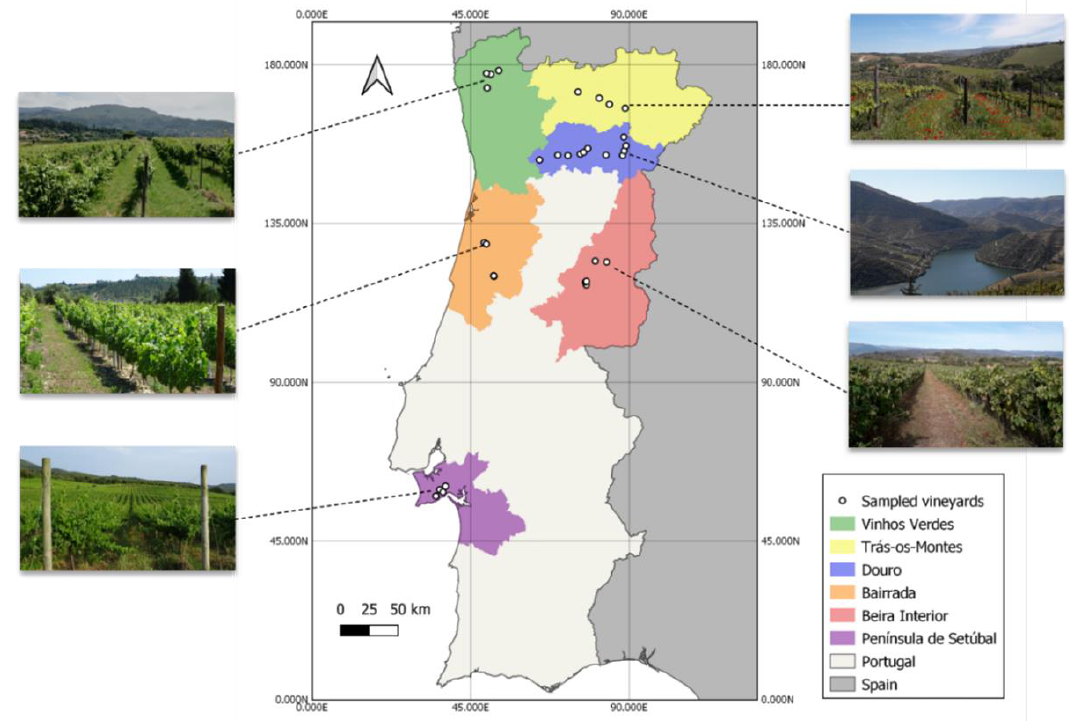
Figure 1. Map of Portugal with indicated sampled vineyards and, respectively PDO Wine Region. The map was projected in ETRS89/PT-TM06.